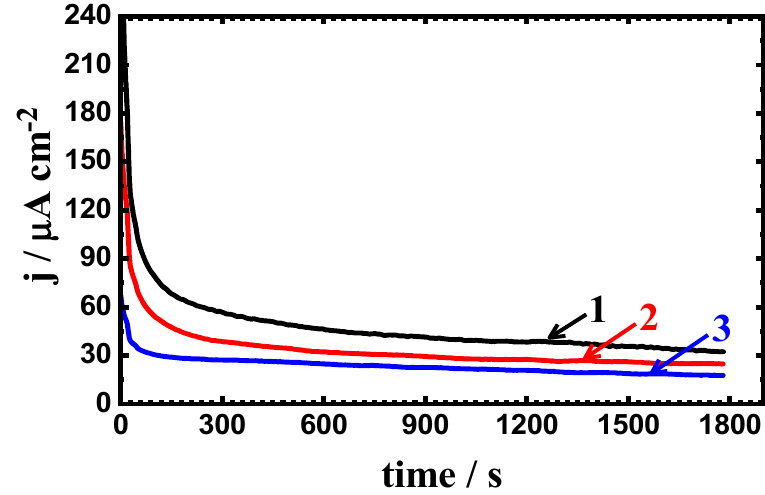
Figure 8. Change of current with time curves for (1) PS, (2) PSC1, and (3) PSC2 at − 700 mV in 4% NaCl solution after 1.0 h of exposure.